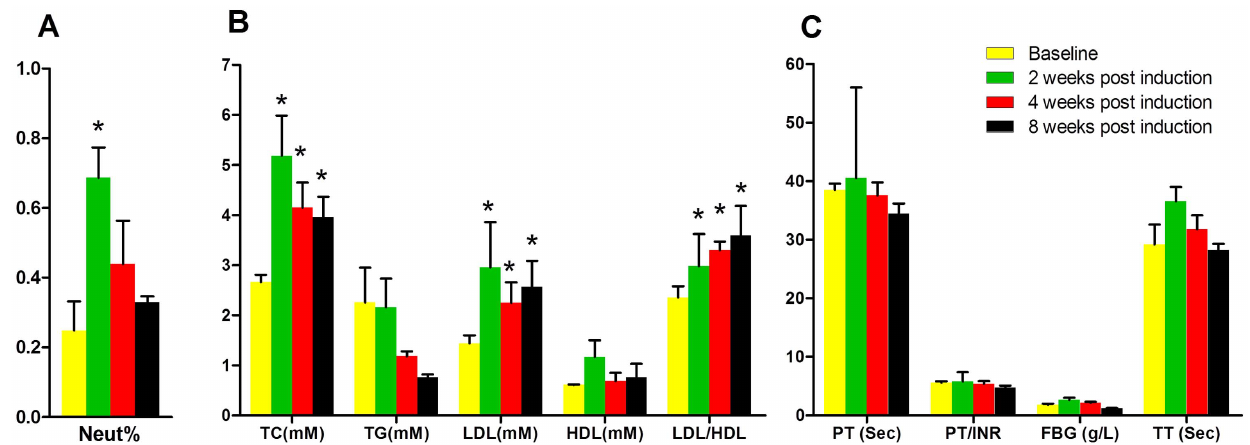
Figure 2. Hematological evaluation of emus in SAON group. (A) Time course changes in percentage of neutrophils (Neut %) in blood: Neut% was significantly increased at 2 weeks post SAON-induction (*: p , 0.05, compared with baseline, n=5). (B) Time course changes in serum parameters related to lipid metabolism: TC significantly increased at each time point post SAON-induction. LDL and the ratio between LDL and HDL also significantly increased at each time point post SAON-induction (*: p , 0.05, compared with baseline, n=5). (C) Time course changes in serum parameters related to coagulation: no significant difference was found in coagulation-related parameters after induction as compared with baseline.